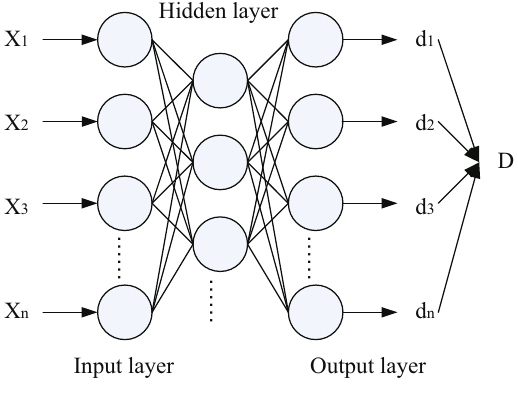
Figure 4: The basic structure of